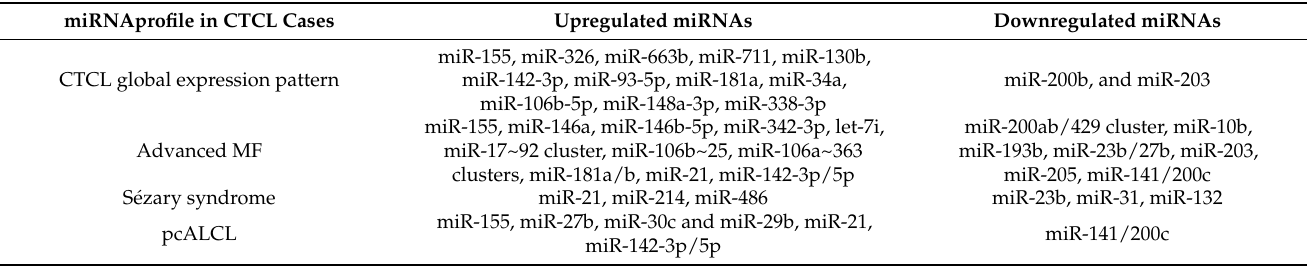
Table 3. Differentially expressed microRNAs in CTCL.